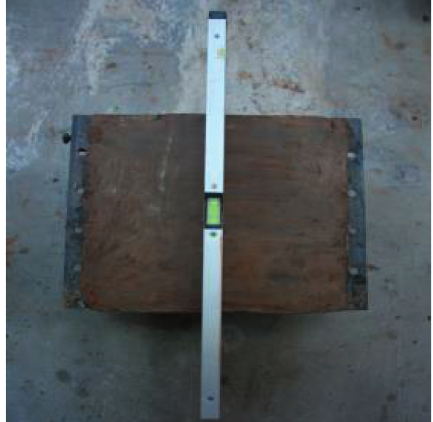
Figure 10: Repairing the soil on the surface.